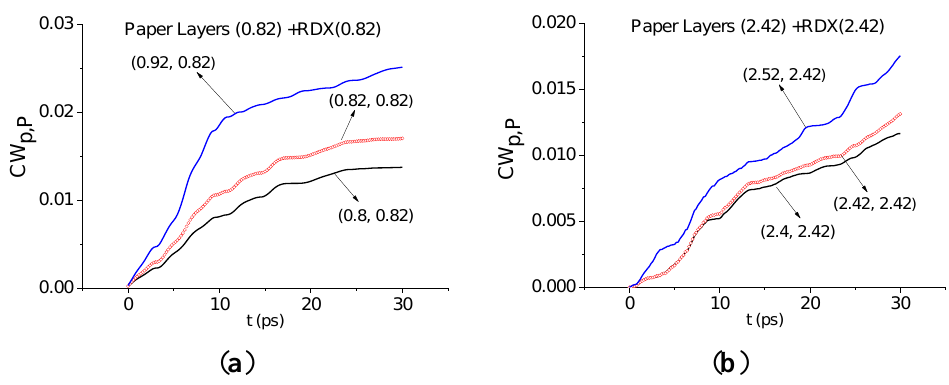
Figure 9. Integral characteristics CW p , P ( t n ) detecting the frequencies ν = 0.82 THz ( a ); 2.42 THz ( b ) THz for Paper Layers signal with RDX_Air as a standard